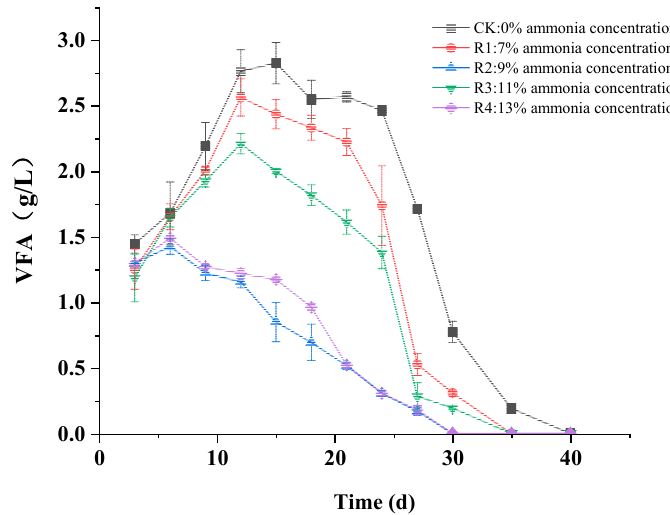
Figure 2. The VFA concentration of different pretreatment conditions.